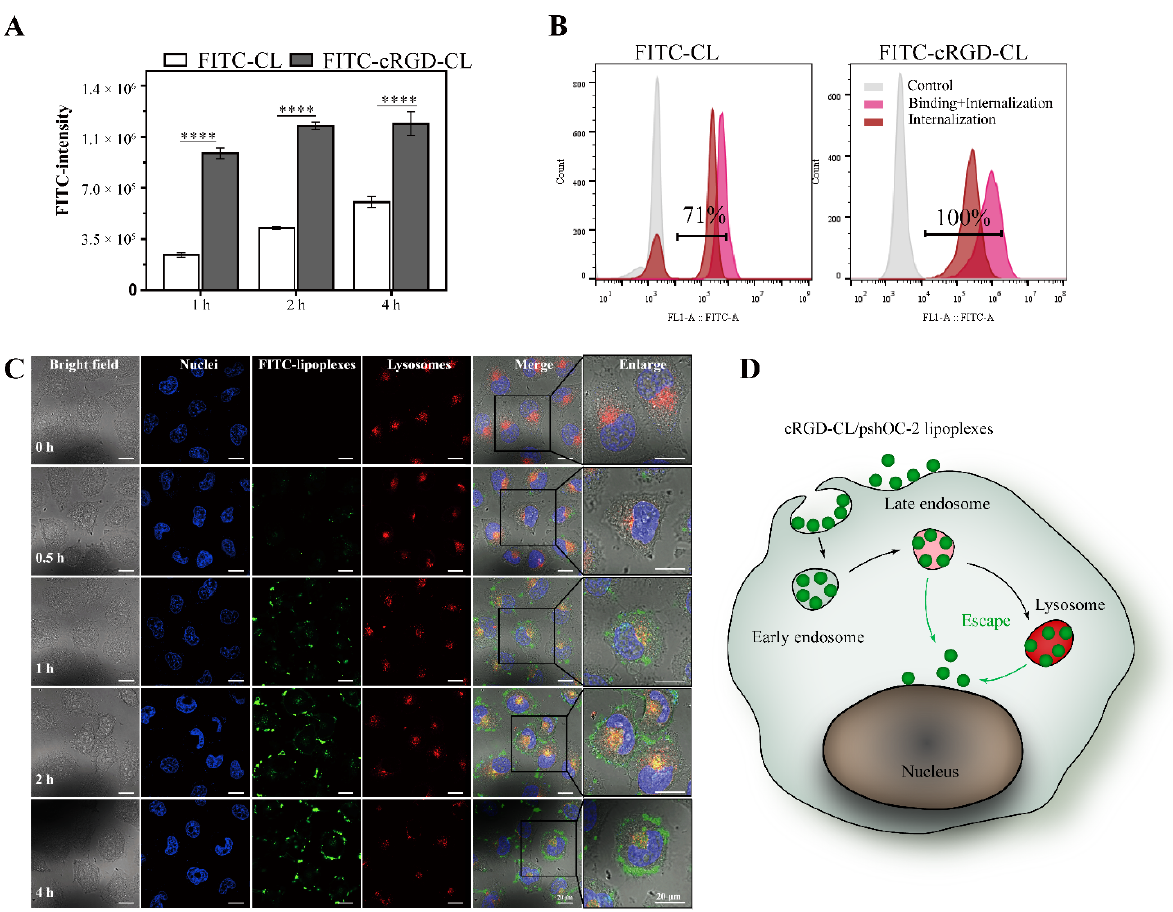
Figure 3. Cellular Uptake of cRGD-CL in MCF-7 Cells. ( A ) The FITC intensity of MCF-7 cells after incubation with FITC-labelled CL and cRGD-CL for 1, 2 and 4 h. ( B ) FCM results of MCF-7 cells after incubation with FITC-labelled CL and cRGD-CL for 4 h with or without 0.4% Trypan blue ( C ) Intracellular trafficking of FITC-cRGD-CL/pshOC-2 in MCF-7 cells. Cells were incubated with FITC-cRGD-CL/pshOC-2 (green) for 0.5, 1, 2 and 4 h and then labeled with Lyso-Tracker (red) and DAPI (blue) to display the lysosome and nucleus. Scale bar: 20 μm. ( D ) Schematic diagram of intracellular trafficking of FITC-cRGD-CL/pshOC-2 lipoplexes in MCF-7 cell after endocytosis. Data were presented as mean ± SD, **** p < 0.0001.